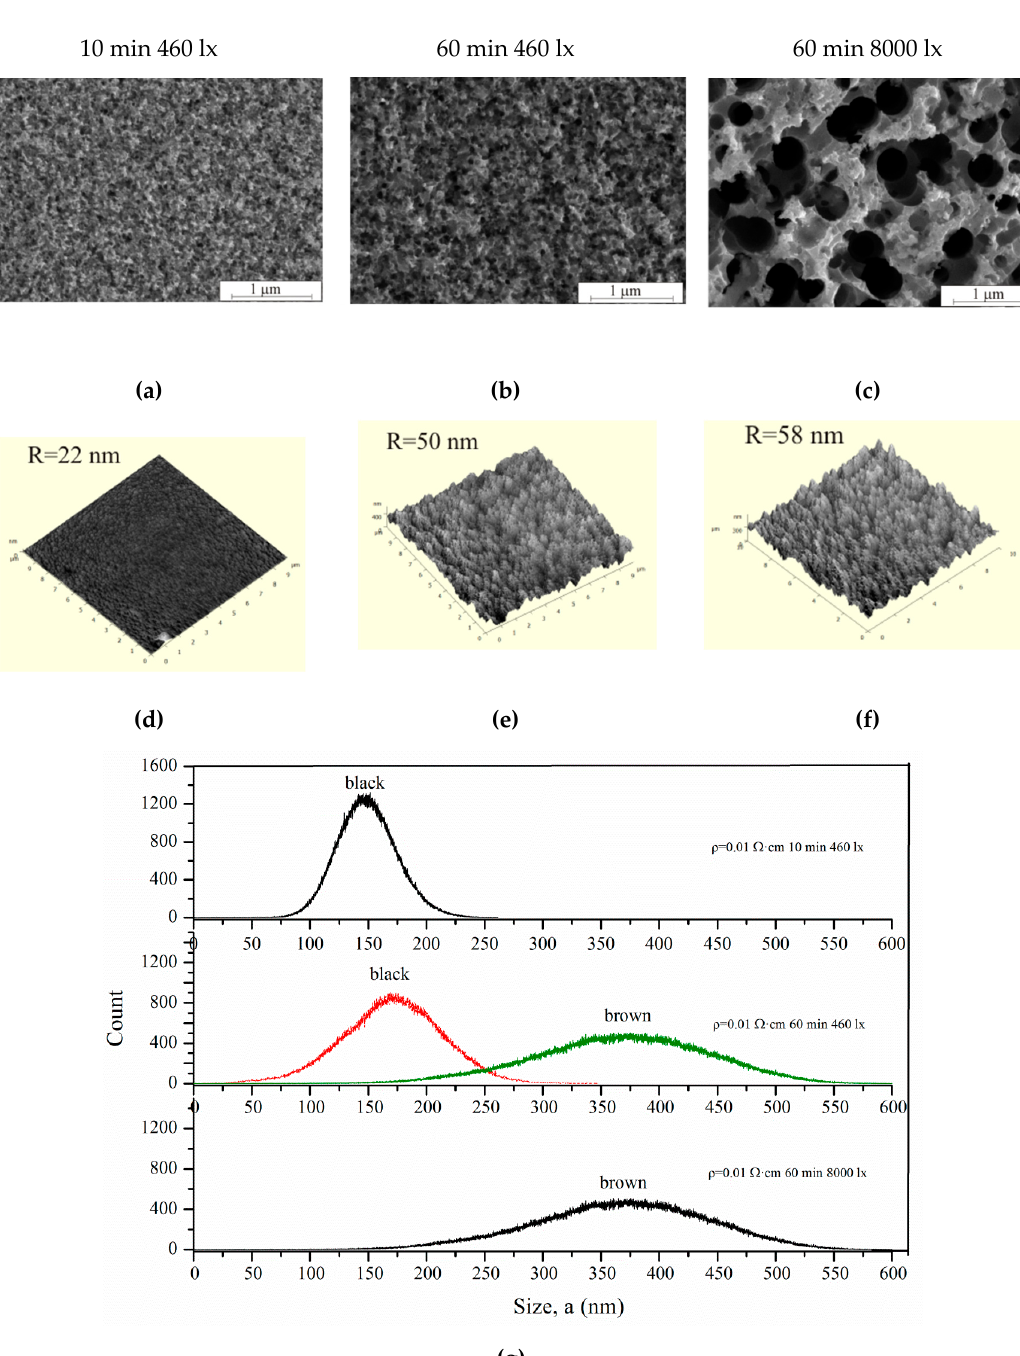
Figure 9. Morphology evolution of porous silicon by photo-assisted etching inspected after ( a , d ) 10 and ( b , c , e , f ) 60 min under ( a , b , d , e ) 460 and ( c , f ) 8000 lx illumination. ( a – c ) SEM images, ( d – f ) AFM images, and the ( g ) wall thickness of black and brown silicon.